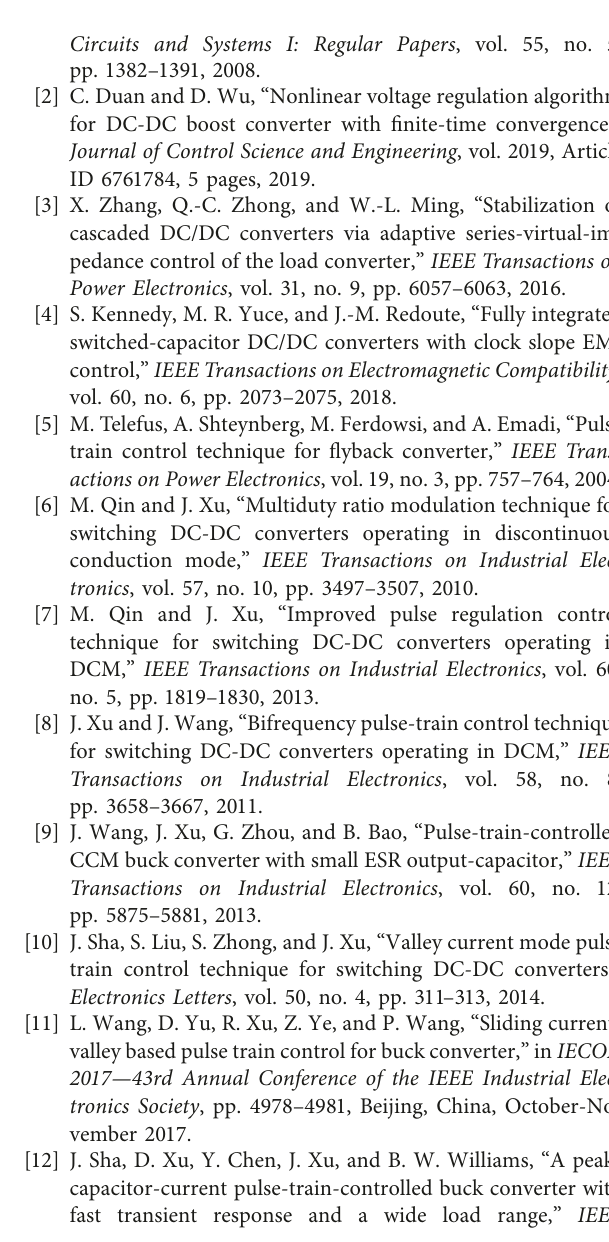
Figure 10: Experimental waveforms.(a) DCPT-controlled buck converter. (b) PT-controlled buck